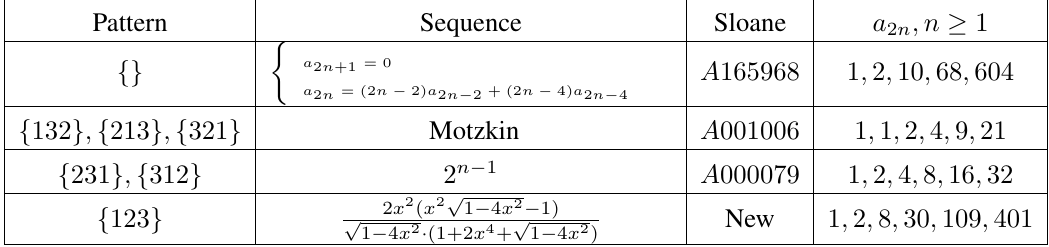
Tab. 3: Fixed point free irreducible involutions avoiding at most one pattern of S 3